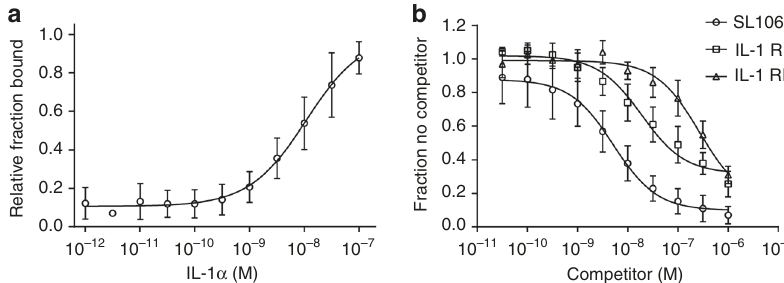
Fig. 7 Determination of the binding af fi nity of SL1067 to IL-1 α and the competition of IL-1 α receptors with SL1067. a Shown is a four-parameter global fi t (mean ± S.D., n = 4) of the relative fraction bound vs. IL-1 α concentration. The mean ( ± S.D.) binding dissociation constant ( K d ) determined from the four independent experiments is 7.3 ± 1.5 nM. b Displacement of radiolabeled SL1067 by unlabeled competitors SL1067 ( open circles ), IL-1 RI ( open squares ) or IL-1 RII ( open triangles ). Shown is a global fi t (mean ± S.D., n = 3) to a one-site competition model of competitor concentration vs. fraction no